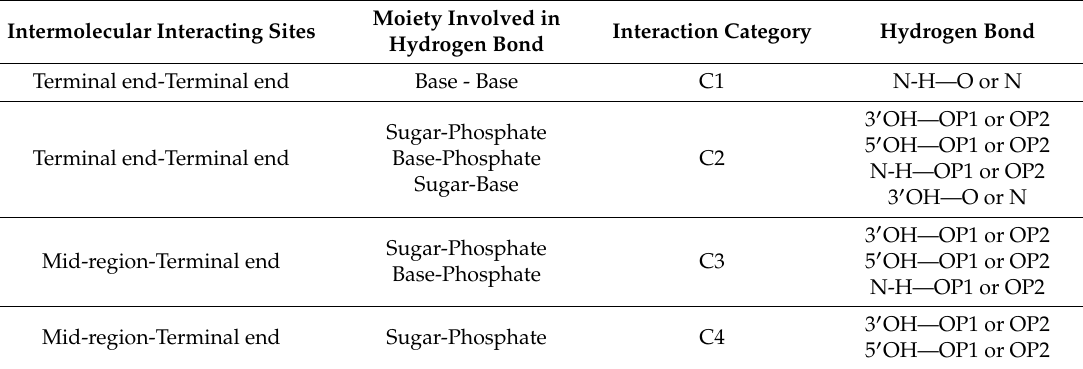
Table 1. DNA crystal packing interaction.